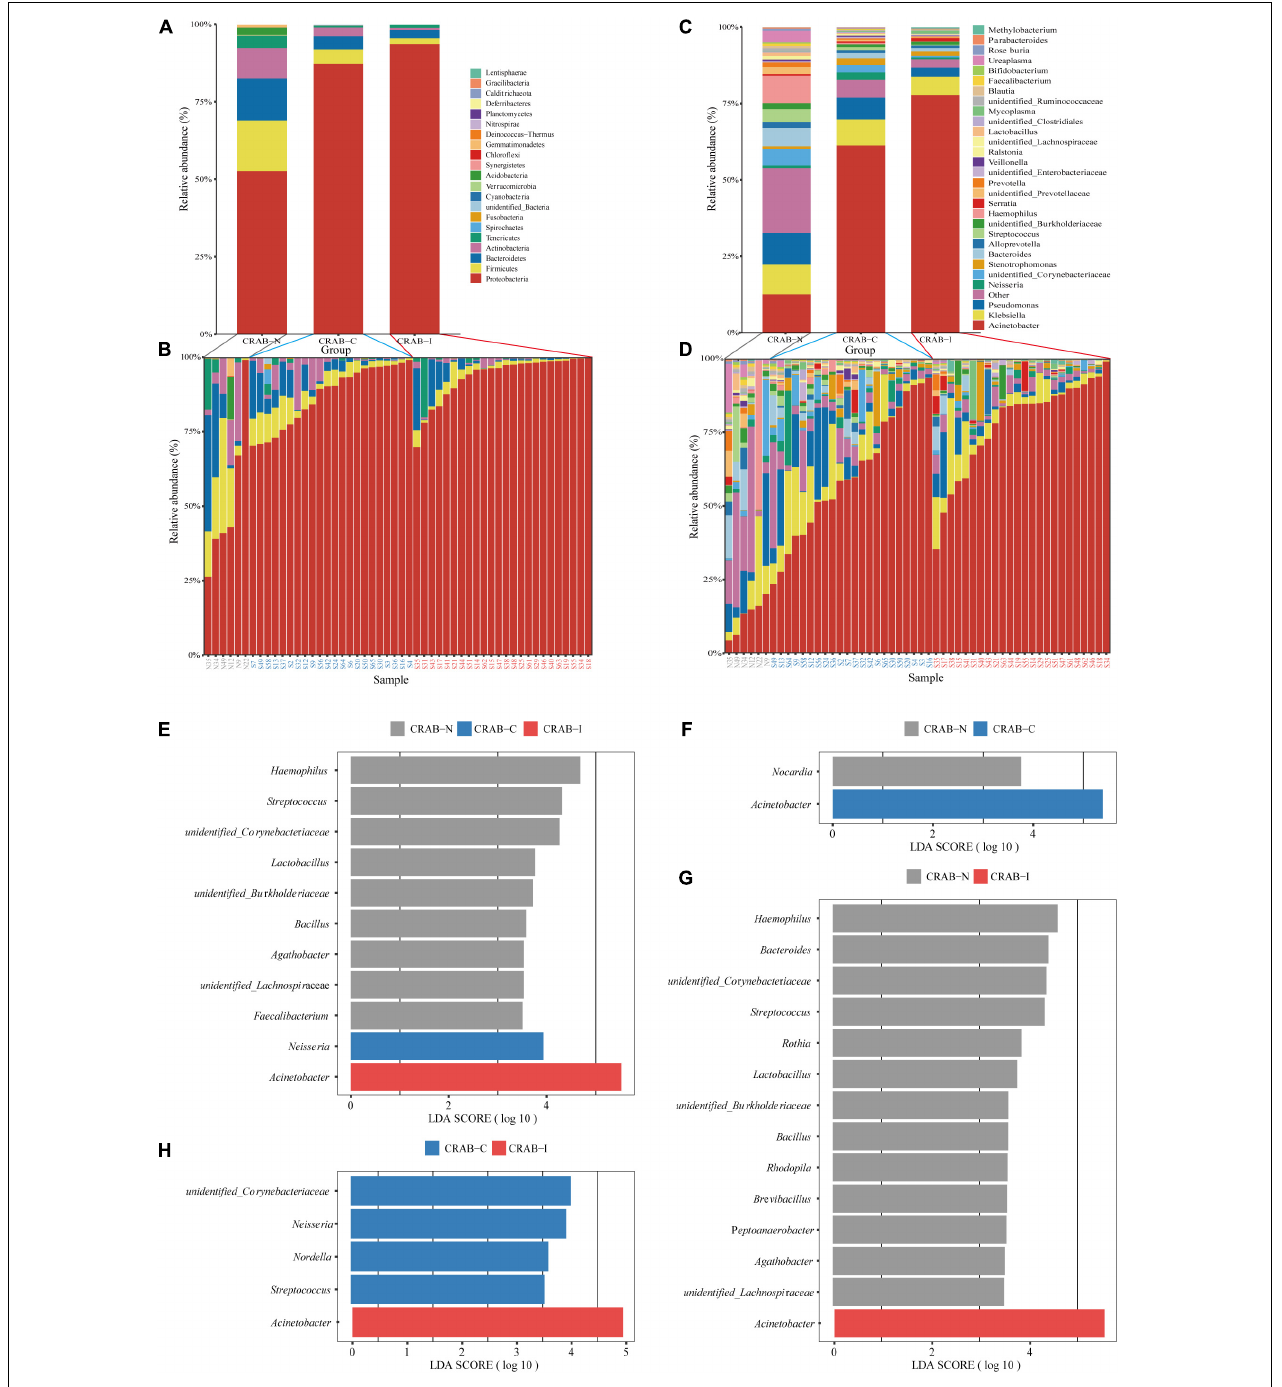
FIGURE 3 | Comparison of phylum and genus of the LRT microbiota in the three patient groups and linear discriminant analysis effect size (LEfSe) analysis of the microbiota at genus level. (A) Comparison of the average abundance of each bacterial phylum in each group, respectively. (B) Comparison of the average abundance of bacterial phylum in each patient, respectively. (C) Comparison of the average abundance of each bacterial genus in each group, respectively. (D) Comparison of the average abundance of bacterial genus in each patient, respectively. The changes per patient are visualized in as dashed lines dark red for CRAB-I, in blue for CRAB-C and in gray for CRAB-N. (E) LDA scores indicated significant differences in the microbiota among the CRAB-N (gray), CRAB-C (blue), and CRAB-I patients (red). (F) LDA scores indicated significant differences in the microbiota between the CRAB-N (gray) and CRAB-C patients (blue). (G) LDA scores indicate significant differences in the microbiota between the CRAB-I patients (red) and CRAB-N controls (gray). (H) LDA scores indicate significant differences in the microbiota between the CRAB-I (red) and CRAB-C patients (blue). LDA scores > 3.5. The subject group is indicated by the color key at the top right corner.